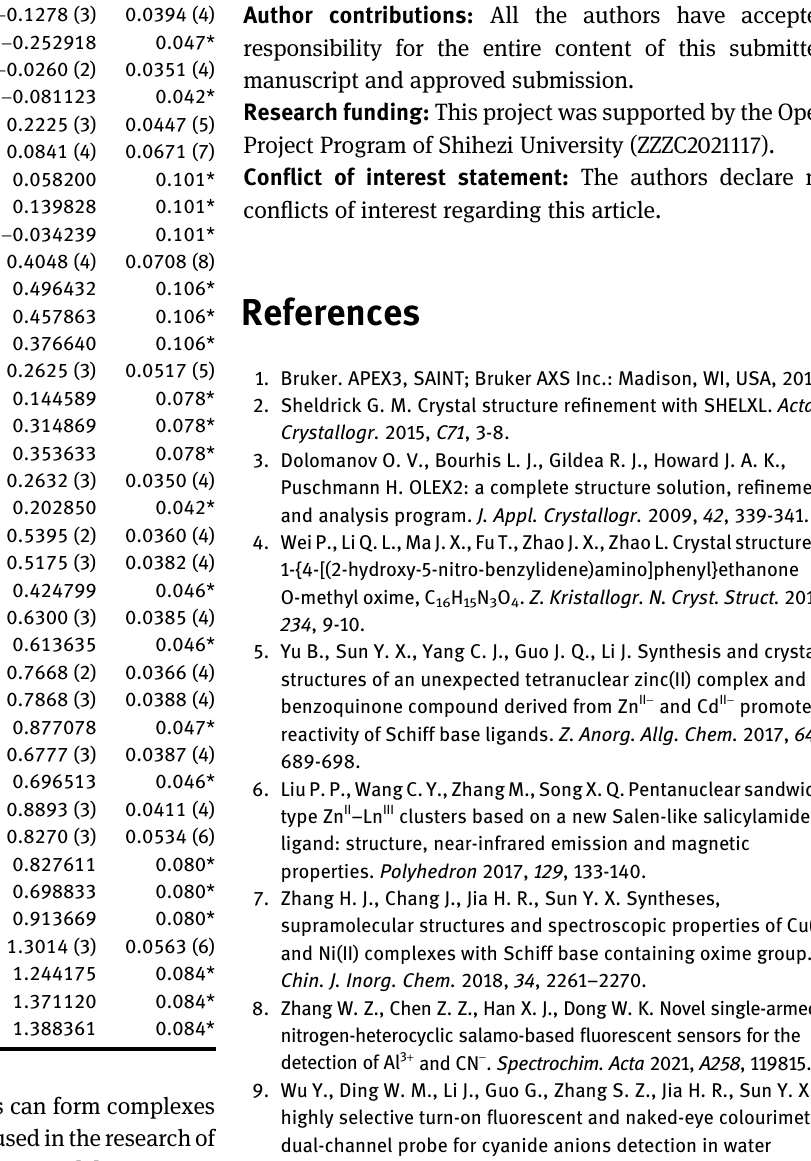
there is a strong intramolecular O1 — H1 / N1 hydrogen bond